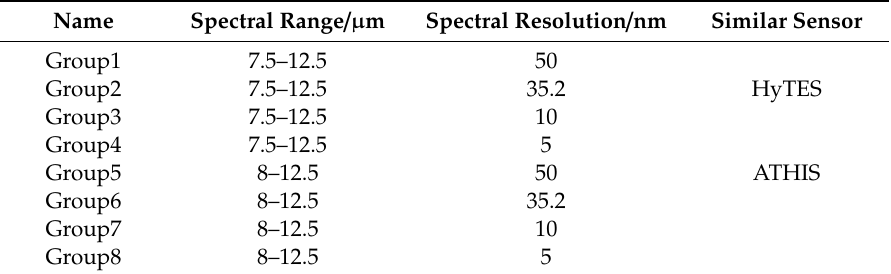
Table 2. Groups of simulated hyperspectral thermal infrared (HTIR)